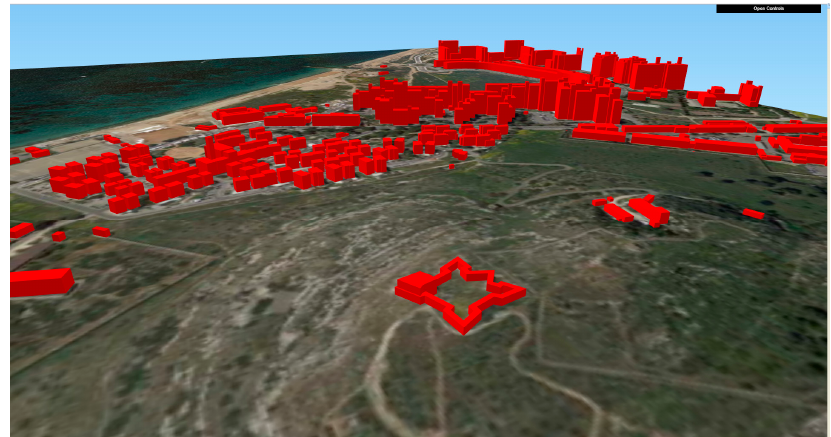
Figure 9. 3D Visualization (S. Ignazio Fort).